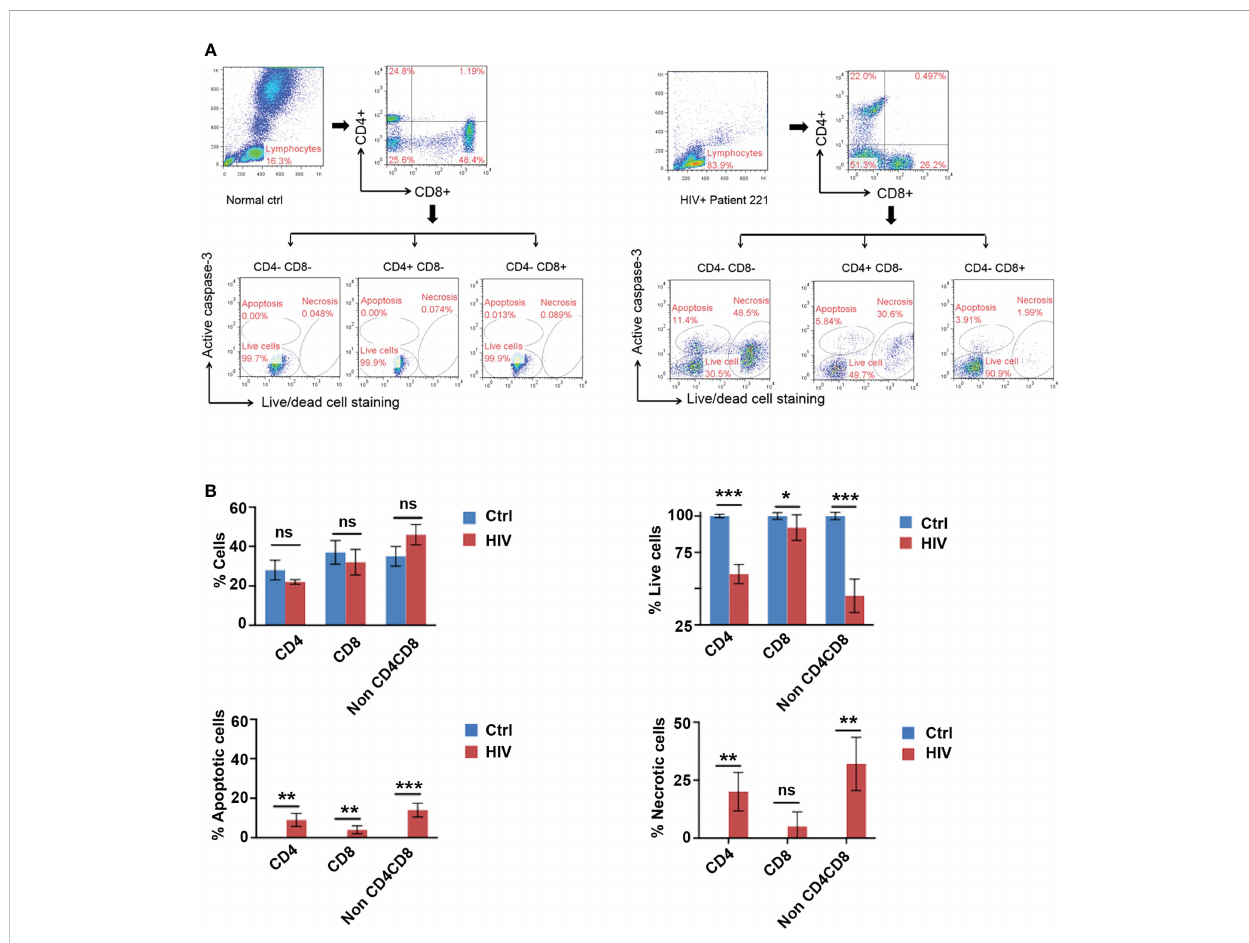
FIGURE 1 Identi fi cation of Apoptosis and Necrosis in Lymphocytes of HIV Infected Patients. (A) Gating strategy: Peripheral blood lymphocytes were fi rst gated in the FSC/SSC (forward scatter/side scatter) properties. Within this population, CD4 + T cells and CD8 + T cells were then identi fi ed based on their speci fi c surface markers. A live-dead fi xable stain in combination with an active caspase-3 antibody was used to differentiate between apoptosis (Caspase-3 + live-dead − ), necrosis (Caspase-3 − live-dead + ), and live (Caspase-3 − live-dead - ) cells. Representative fl ow cytometry plot for cell death of lymphocytes in an HIV-infected patient (#221, right) and a healthy individual 1 (#1, left). (B) HIV infection led to cell death by apoptosis and necrosis in CD4 - /CD8 - , and CD4 + lymphocytes. Frequencies of live lymphocytes and their apoptotic/necrotic death in HIV infected patient blood (HIV)